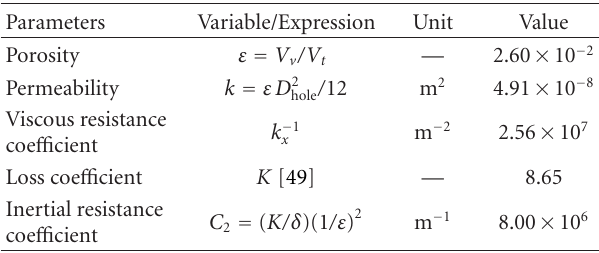
Table 6: PBP parameters: porous